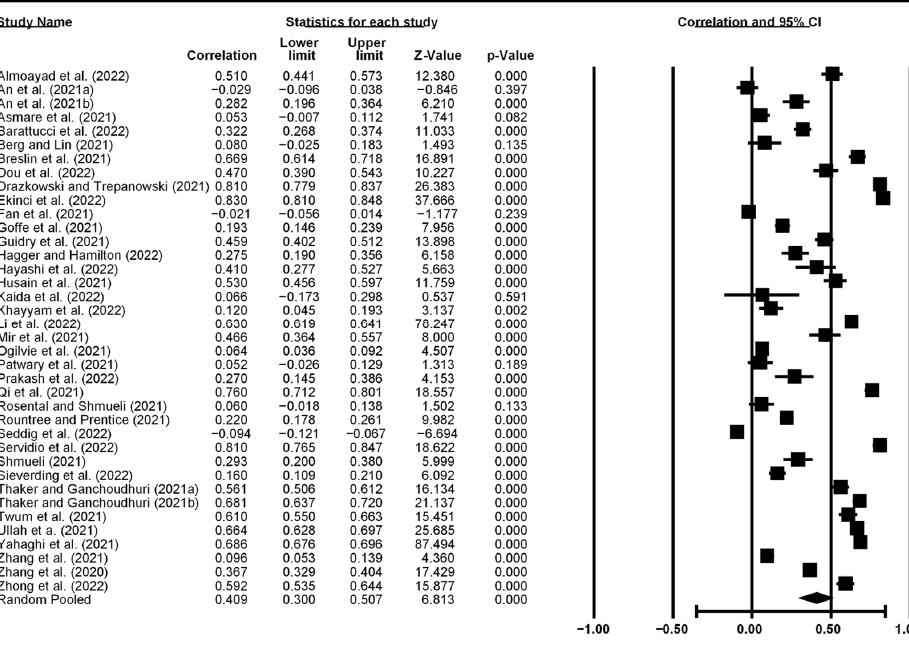
Figure 2. Forest plot showing attitude and vaccination intention correlation.